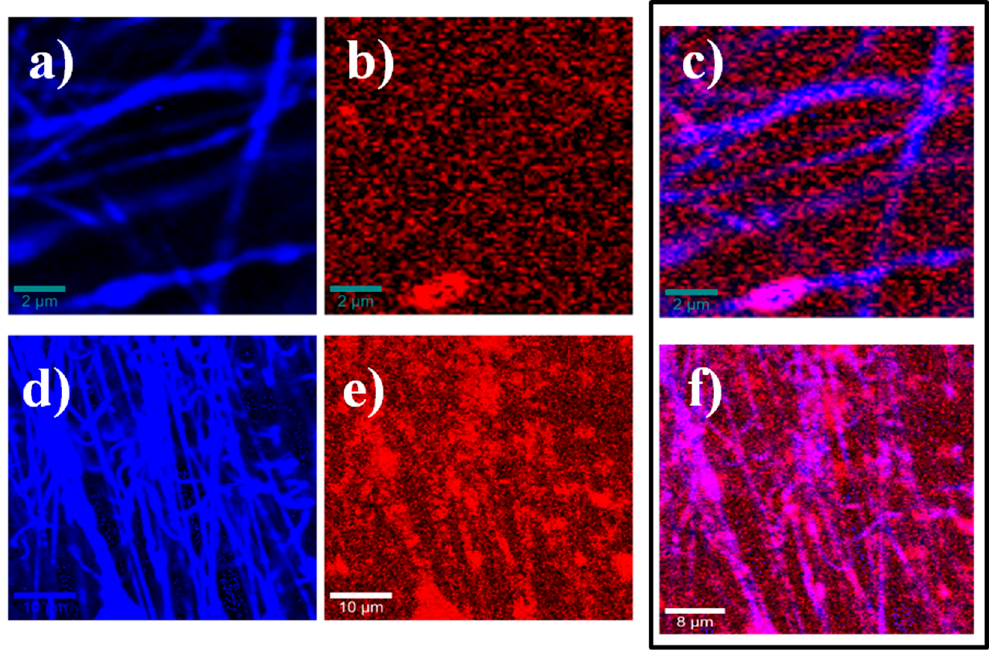
Figure 13. Raman images of electrospun IC nanofibers: PCL/ β -CD ( a – c ); β -CD-NH 2 IC nanofibers ( d – f ). The multivariate data analysis algorithms for HCA (hierarchical cluster analysis) were used to discriminate between the signals and represent the distribution in the IC fibers. In blue , the image by integration for the peak at ~1700 cm − 1 is attributed to the C–H stretching vibrations in PCL; in red , the integration for the peak at ~500 cm − 1 is attributed to the different cyclodextrins. Finally, the images ( c , f ) show the combined images for each IC, showing in purple the distribution of cyclodextrin on the PCL.